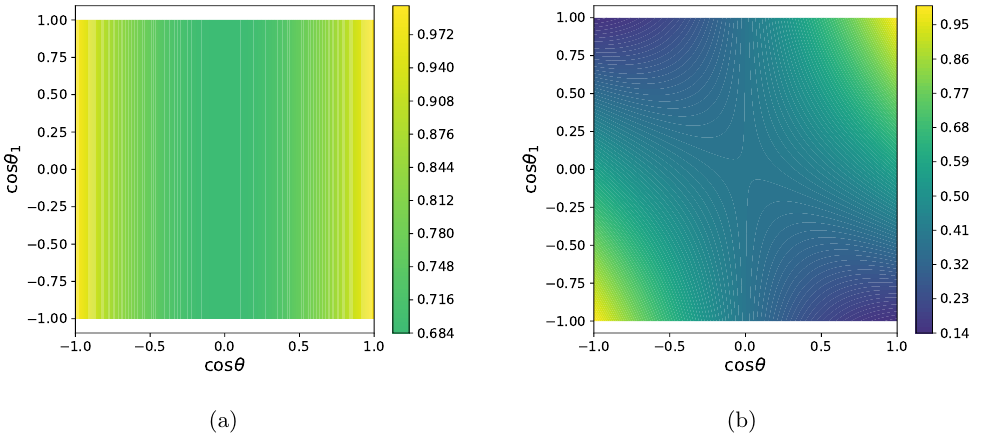
Figure 4 . Di(cid:11)erential distribution in the polar angles (cid:18) and (cid:18) 1 from eq. (2.33). Left: unpolarized beam, (cid:24) = 0. Right: polarized beam with (cid:24) = +1. Color scale is the same for the both